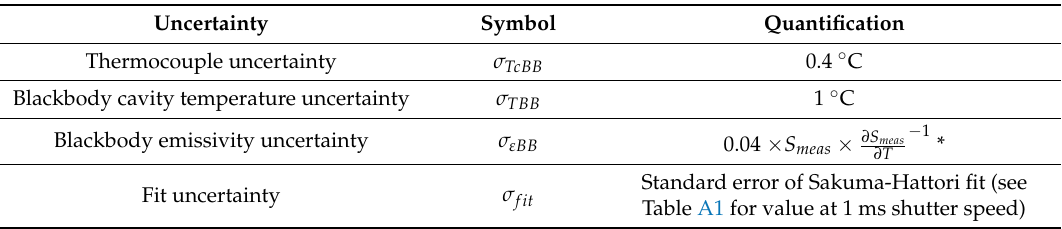
Table A1 for value at 1 ms shutter